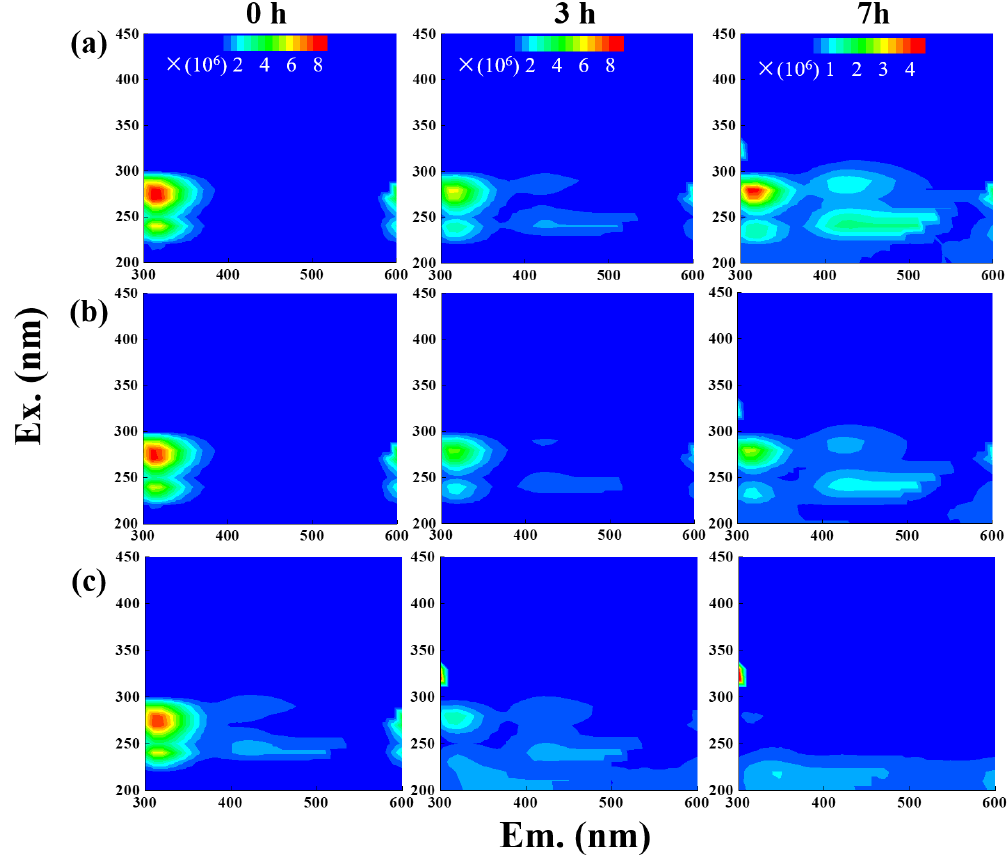
Figure 6. EEM fluorescence spectra of the initial solution (0h) and those at different reaction time (3 and 7h) under (a) direct photolysis, (b) OH-initiated oxidation, and (c) 3 C ∗ -initiated oxidation.